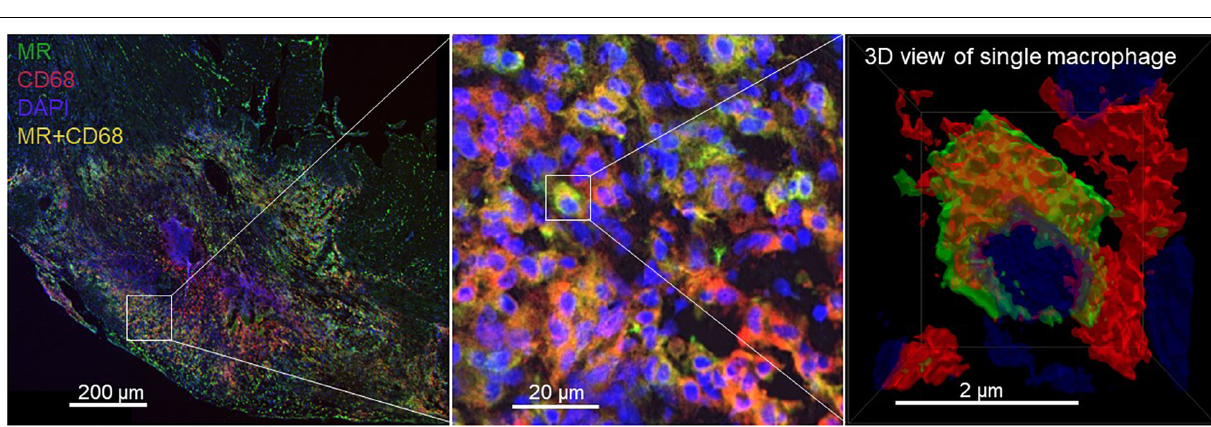
FIGURE 7 | Photomicrographs of MR (green) and CD68 (red) immunofluorescence staining. DAPI stained nuclei are shown in blue. Overlapping domains of MR and CD68 expression are shown in yellow. A portion of CD68 + macrophages located in the 7-day-old infarcts excised from rats showed MR